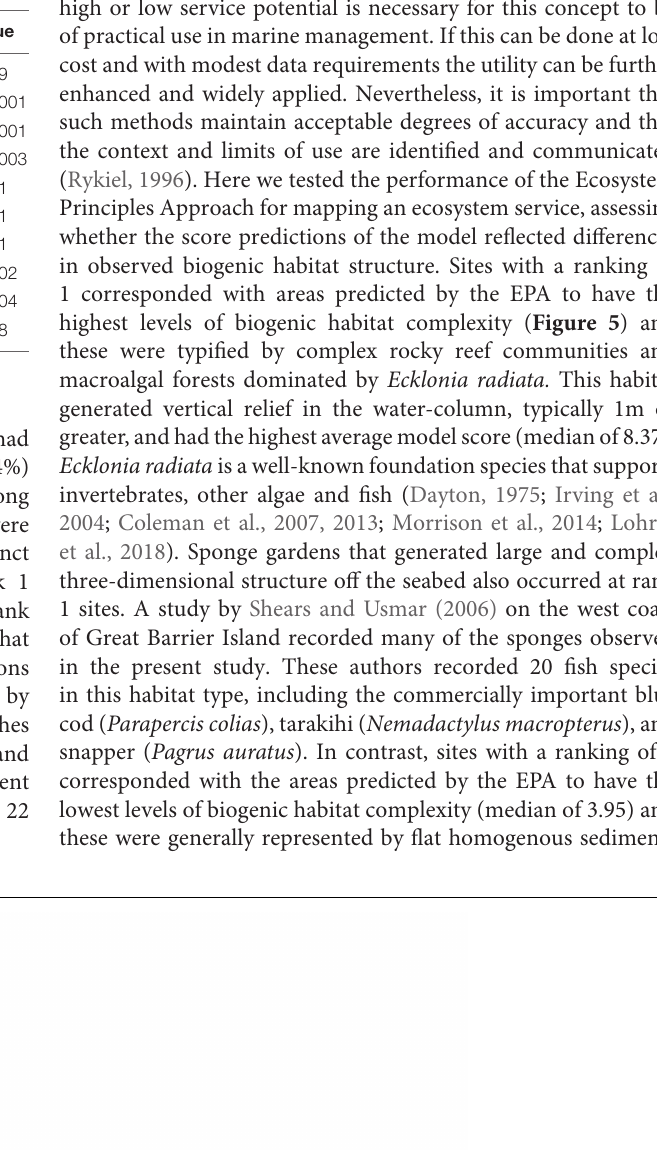
Frontiers in Marine Science |